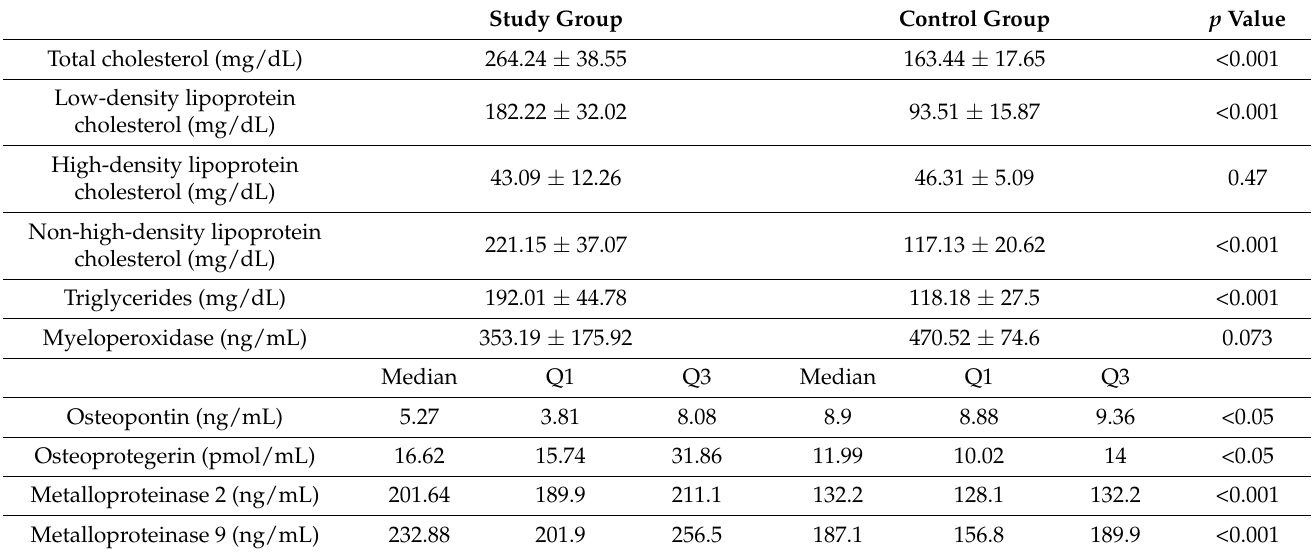
Table 2. Cholesterol fraction and cytokine levels in the study and control group. Q1 is the first quartile; Q3 is the third quartile. Study Group Control Group p Value 264.24 ± 38.55 163.44 ±